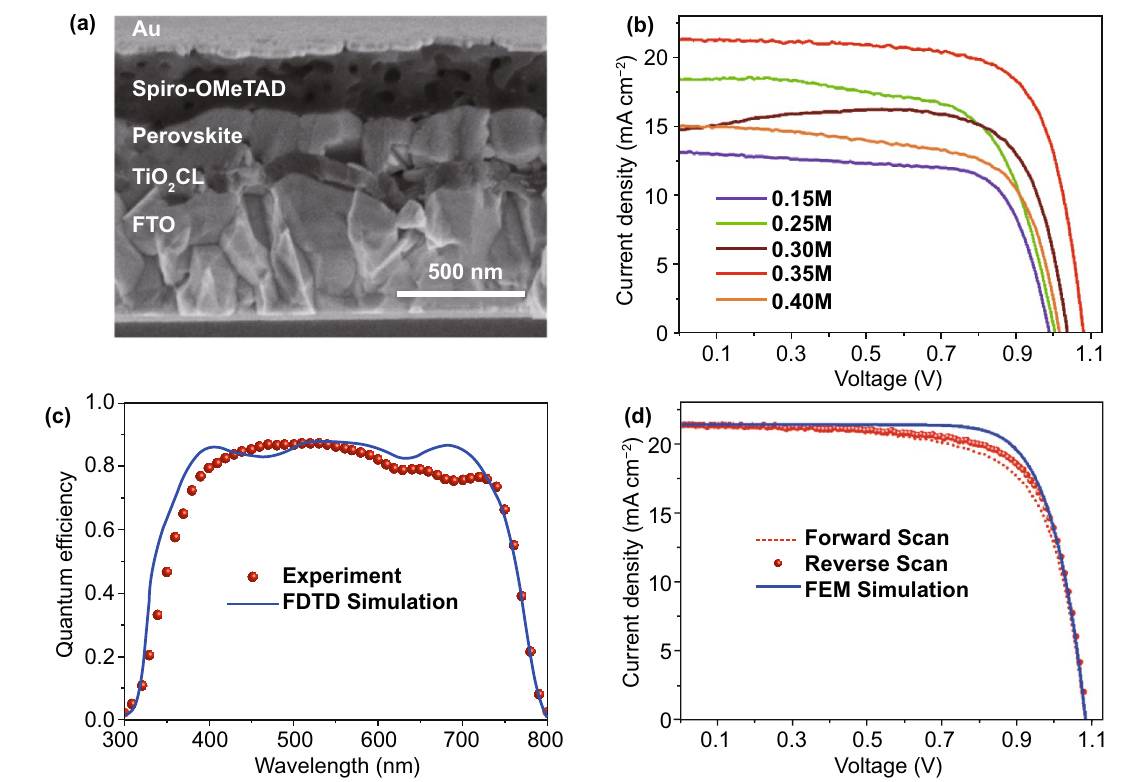
Fig. 2 a Cross‑sectional FESEM image of the fabricated champion planar perovskite solar cell. b Current–voltage ( J-V ) curves with the reverse scan (RS) for the fabricated planar PSCs with different TiO 2 precursor solution concentration. c Comparison of quantum efficiencies between experiment and FDTD optical simulation. d Forward scan (FS) and reverse scan (RS) J-V curves of the fabricated best performing PSC along with the J-V curve realized from the FEM electrical